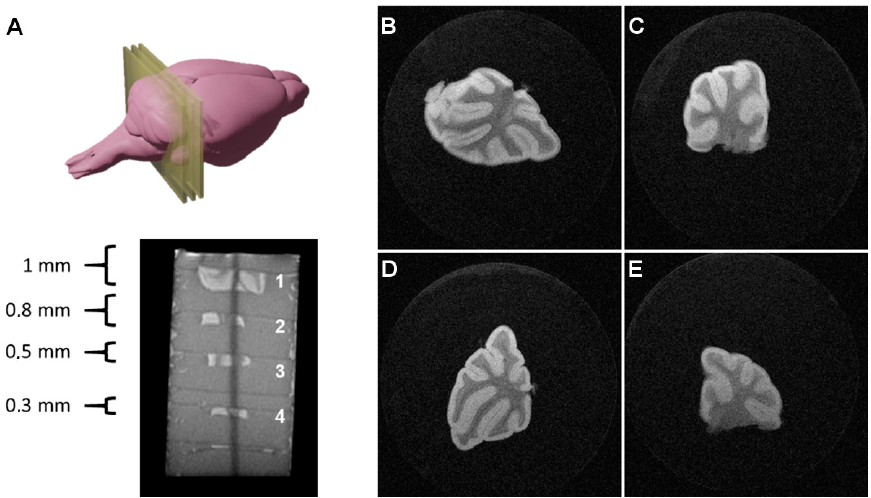
Figure 2. MR imaging of thick tissue slices: ( A ) mouse cerebellum tissue slices excised at different thicknesses and stacked in agar (sagittal MR image); ( B – E ) coronal MRI 2D images (300 µm slice thickness) acquired at two in-plane resolutions. White matter structures (hypointense on T2w imaging) are clearly distinguishable from gray matter .